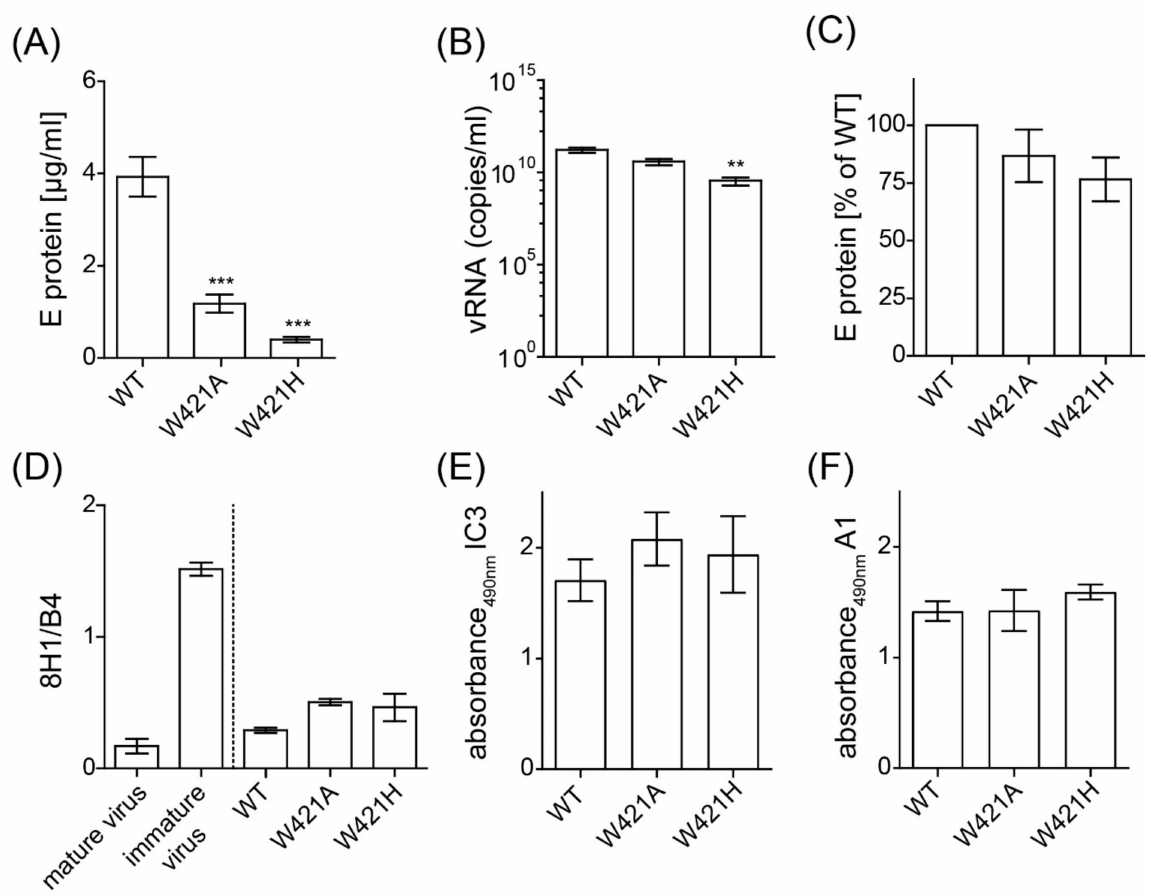
Figure 2. Quantification of E protein as well as viral RNA in the cell culture supernatants 48 h after transfection with WT and mutants and characterization of particle formation. ( A ) Concentration of E detected in the cell culture supernatant as determined by a quantitative ELISA. ( B ) Concentration of viral RNA in the cell culture supernatant as determined by qPCR. ( C ) Analysis of particulate nature of viral material in cell culture supernatants. Samples were subjected to ultracentrifugation and the amount of E in the pellet was determined by quantitative ELISA. Results are expressed as % E relative to WT. ( D ) Resuspended pellets were analyzed in ELISA with a prM-specific (8H1) and E-specific mab (B4) as described in Material and Methods. Immature virus and mature virus were used as controls. Results are expressed as the ratio of the area under the curve obtained with mab 8H1 relative to the one obtained with mab B4. ( E , F ) Resuspended pellets were analyzed in an ELISA with a DI-specific (IC3) and FL-specific mab (A1) as described in Material and Methods. Data are from at least three independent experiments; error bars represent the standard errors of the means (SEM). Asterisks indicate significant differences relative to the WT (ANOVA and Dunnett ´ s multiple comparison test; ** p < 0.01, *** p <